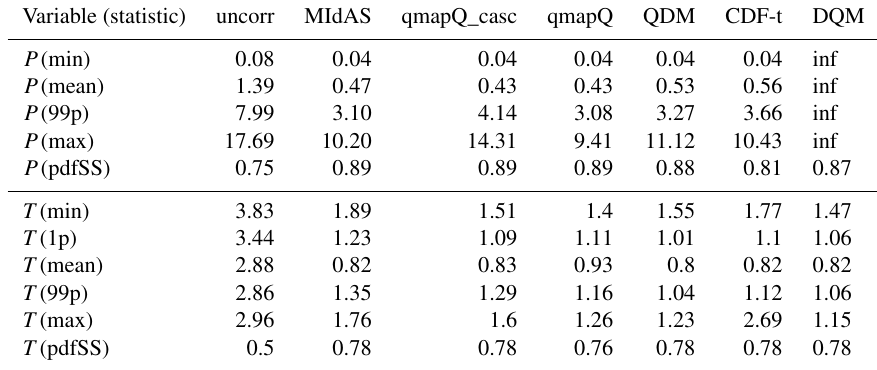
Table 3. Bias as calculated in ranking 1 across all regions, time periods, and months. Occasions where the statistic was strongly affected by outliers is marked “inf”, for infinity (units are mmd − 1 for precipitation and ◦ C for temperature; the pdfSS statistic is unitless). Variable (statistic) uncorr